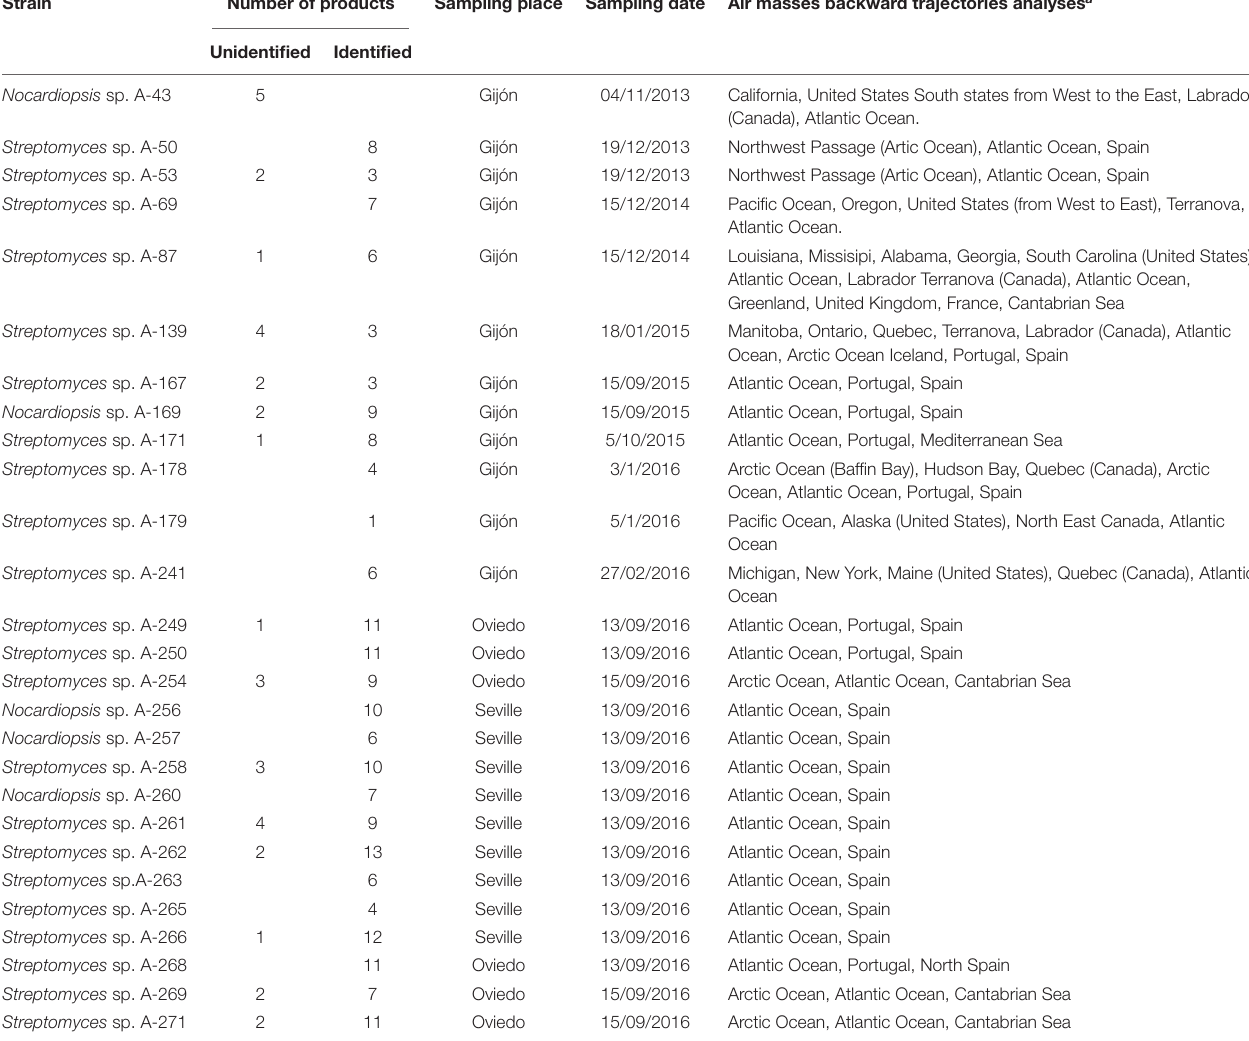
TABLE 5 | Number of compounds and sources of the producing Actinobacteria strains isolated from rainwater precipitations.